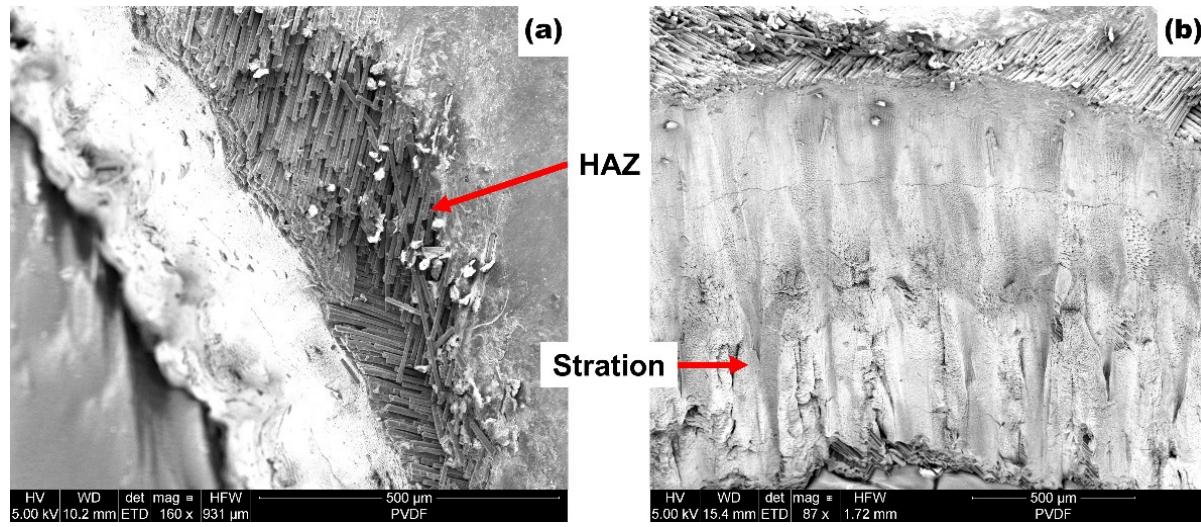
Figure 11. SEM image of drilled CFRP workpiece via stepped laser parameter multiple-ring drilling method: ( a ) top surface; ( b ) cross-section. method: ( a ) top surface; ( b ) cross-section. Table 6. Specific energy consumption and drilling time for each method under the similar drilling